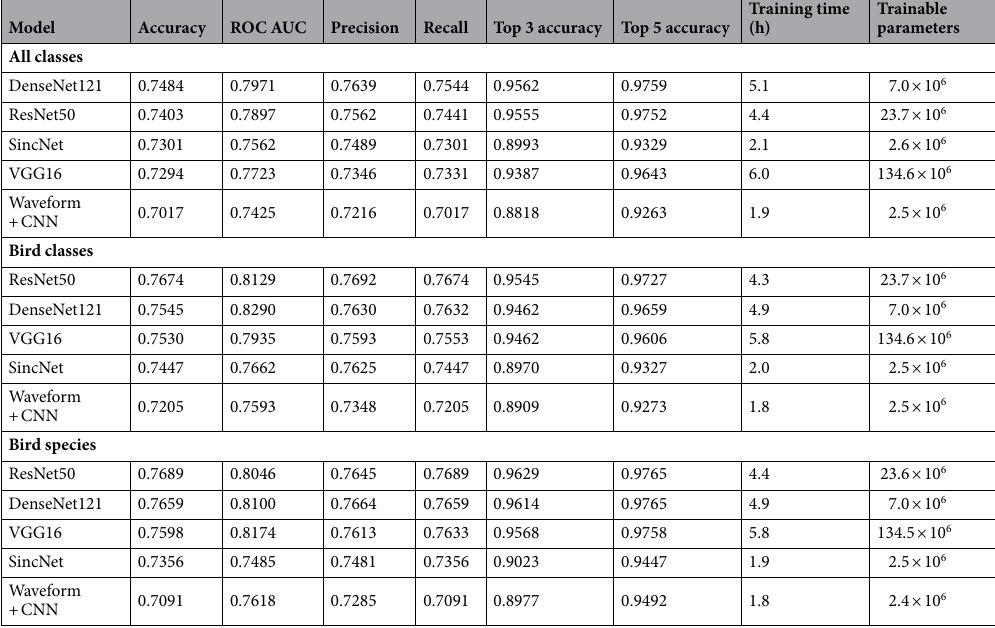
Table 1. Performance metrics, running time and parameter sizes of selected models, grouped by tag selection and then sorted by accuracy.